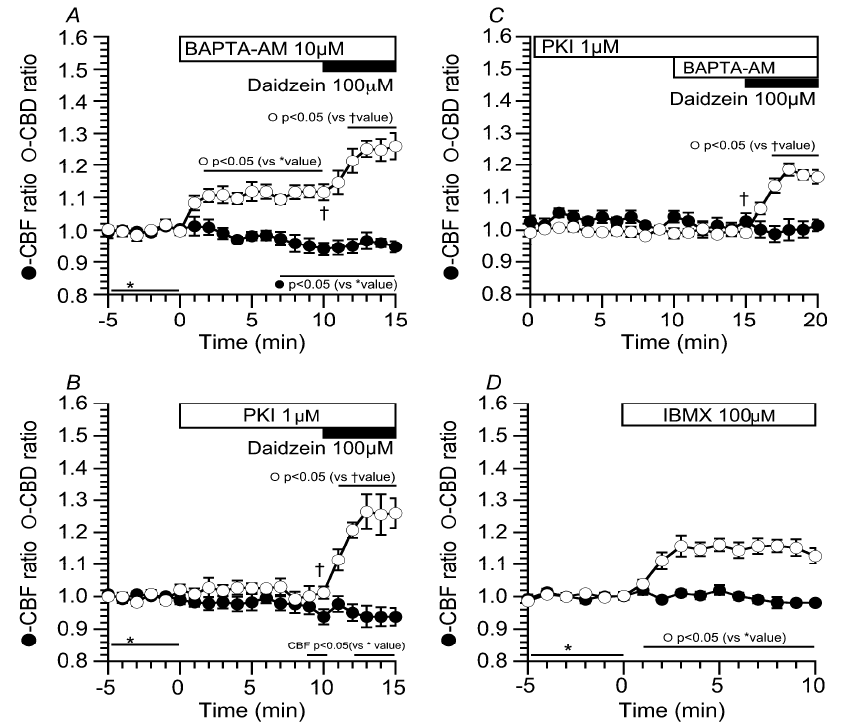
Figure 9. Effects of Ca 2+ and cyclic adenosine monophosphate (cAMP) on daidzein actions. Experiments were carried out in the CO 2 /HCO 3 − -free solution. ( A ) BAPTA-AM (10 µM, O,O' -Bis(2- aminophenyl)ethyleneglycol- N,N,N',N' -tetraacetic acid, tetraacetoxymethyl ester). To chelate intracellular Ca 2+ , cHNECs were treated with 10 µM of BAPTA-AM. The addition of BAPTA-AM phosphodiesterase 1 (PDE1) to accumulate cAMP. Further stimulation with daidzein increased CBD,